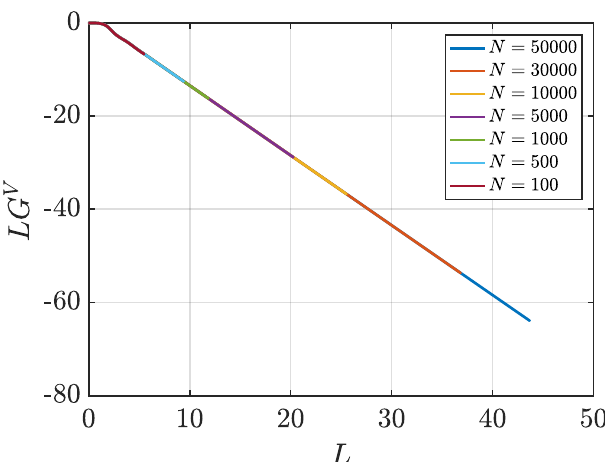
Figure 4. KB integrals of finite subvolumes multiplied by L , LG V (Equation (4)) vs. L for a WCA fluid at T = 2 and ρ = 0.6 (dimensionless units). The values of G V are computed for systems with varying number of molecules N . The used RDFs are provided in Figure 1.